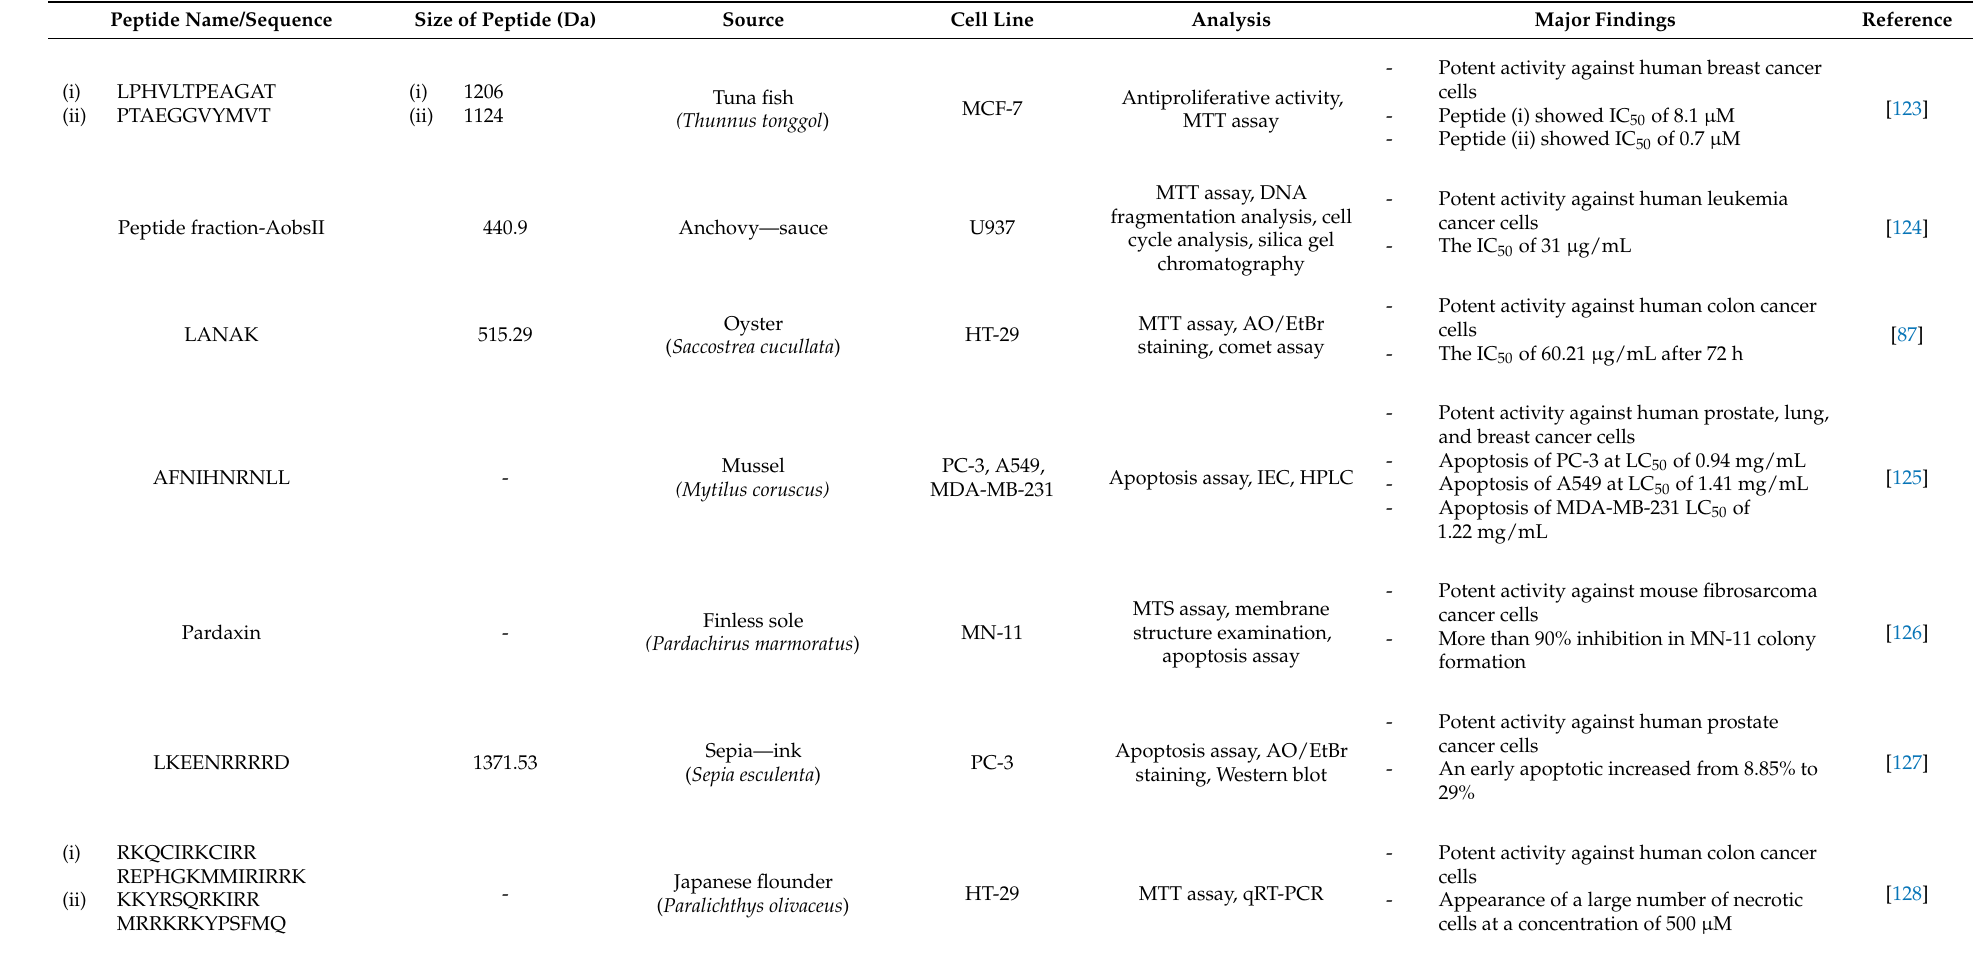
Table 4. Anticancer effects of bioactive peptides from marine animals—in vitro